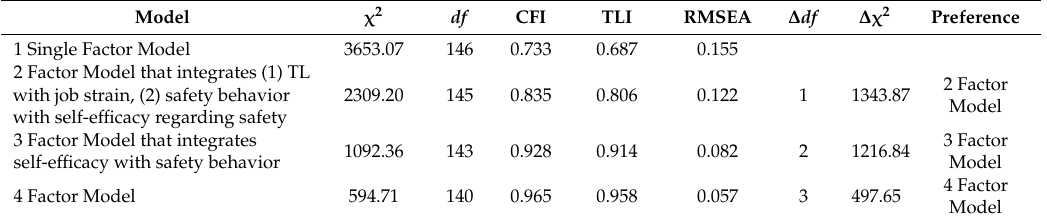
Table 3. Chi-square di ff erence tests among alternative measurement